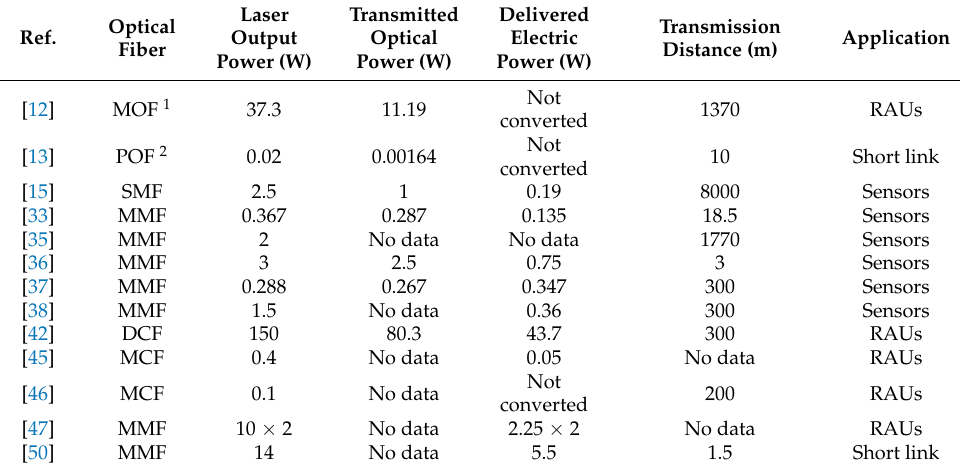
Table 1. Brief summary of the main parameters of PWoF experiments described in this